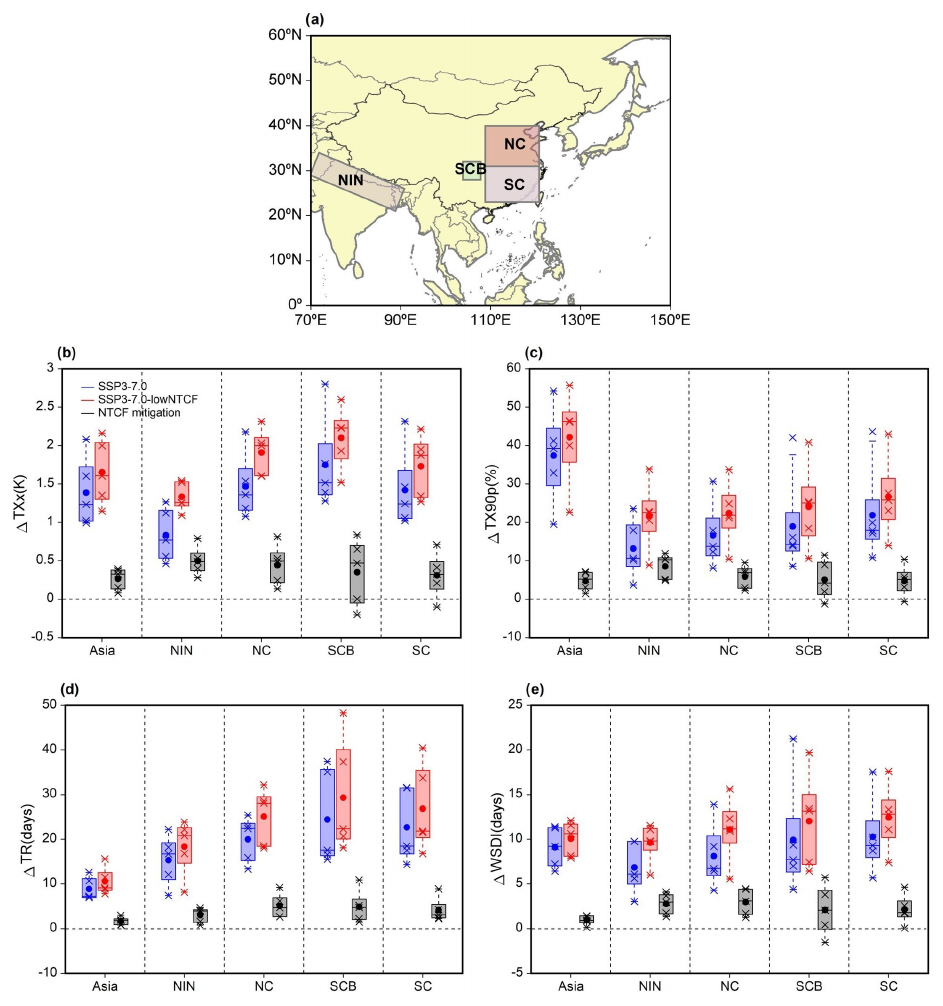
Figure 8. Changes for the hottest day (TXx; b ), warm days (TX90p; c ), tropical nights (TR; d ), and warm-spell duration (WSDI; e ) averaged over NIN, NC, SC, and SCB (a) during 2031–2050 relative to 1995–2014 under the SSP3-7.0 (red) and SSP3-7.0-lowNTCF (blue) scenarios. The grey bars represent the changes caused by the non-methane SLCF reductions. The star symbols indicate the individual models, and the boxes indicate the spread from the 25th to the 75th percentile of the models, with the centre lines representing the median and the dot representing the mean